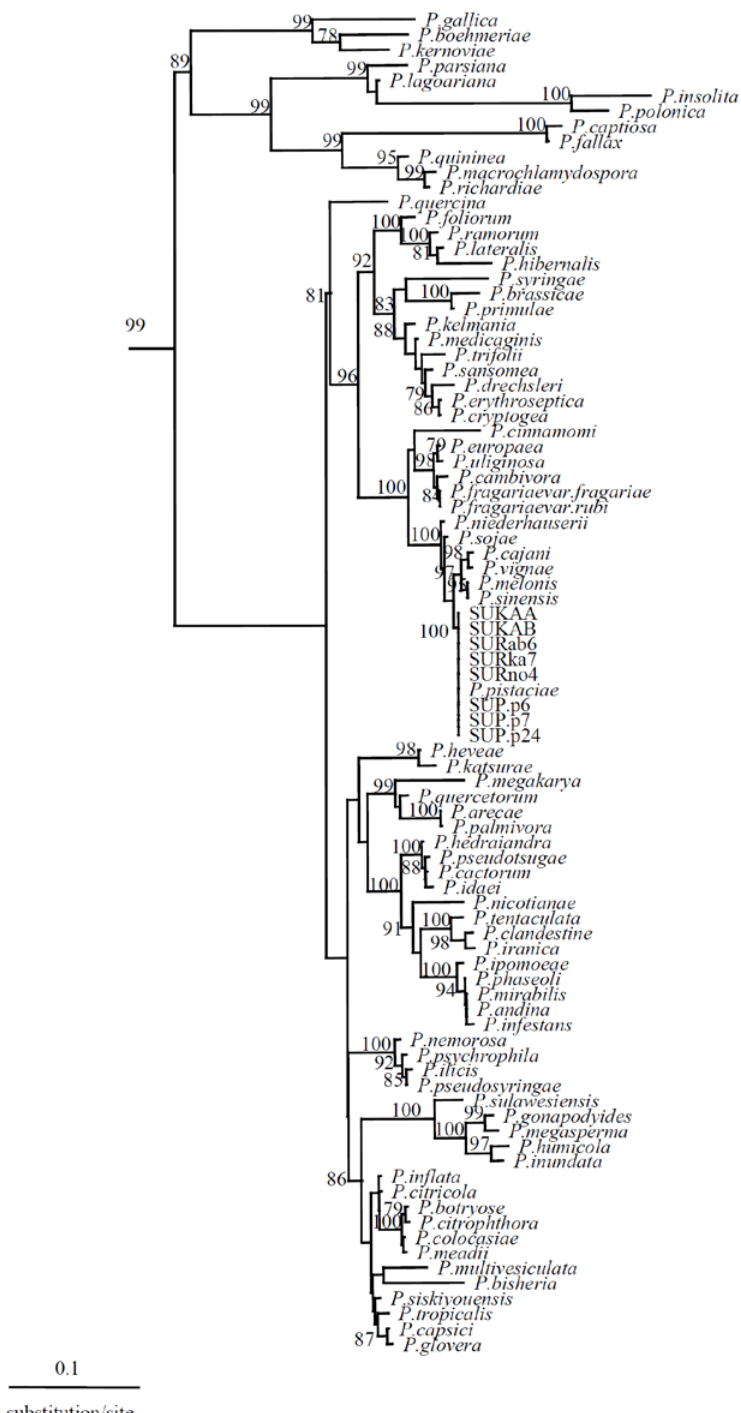
Figure 1. Phylogram of a neighbour-joining analysis of the Phytophthora pistaciae isolates examined in this study, together with 80 Phytophthora species based on the ITS1, 5.8S subunit, and ITS2 regions of the rDNA. The numbers at the branch points indicate the percentages of bootstrap values